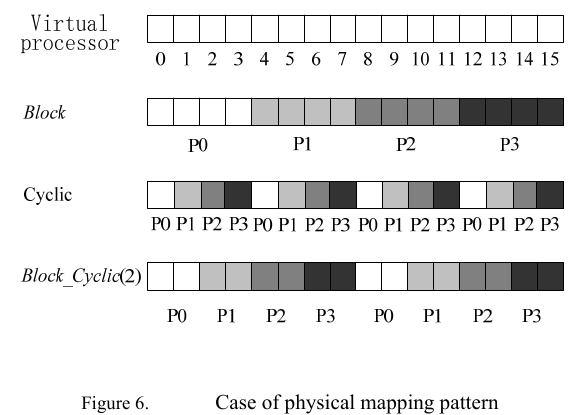
Figure 6. Case of physical mapping